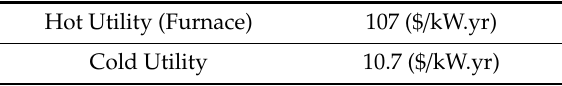
Table 2. Cost data for crude oil preheat